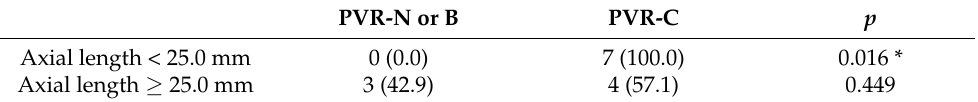
Logistic regression analysis in the propensity-score matched population. PVR-C, proliferative vit- reoretinopathy grade C. * p < 0.05. Table 6. Risk for surgical failures (level 2 or 3) according to axial length in the propensity-score matched population.